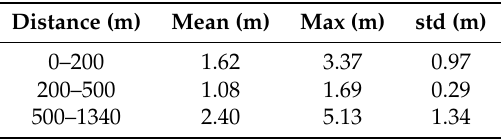
Table 3. Summary of the error